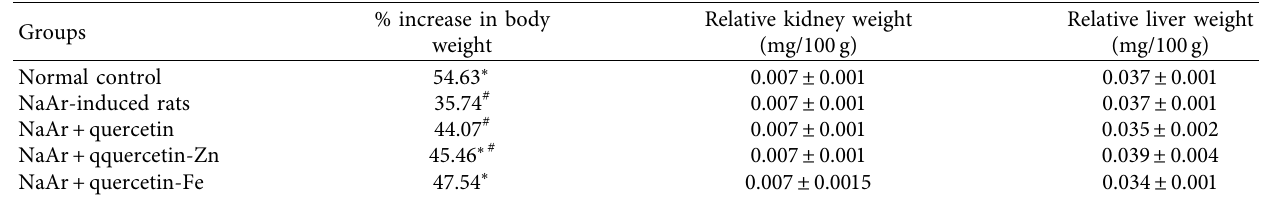
Normal control � normal rats; NaAr-induced rats � sodium arsenate-intoxicated rat; Na-Ar+quercetin � sodiumarsenate-intoxicated rat+30mg/kg quercetin treatment; Na-Ar+quercetin-Zn � sodium arsenate-intoxicatedrat+quercetin-Zn complex treatment; Na-Ar+quercetin-Fe. ∗ signifcant dif- ference with sodium arsenite intoxicated rats, # signifcant diference with control